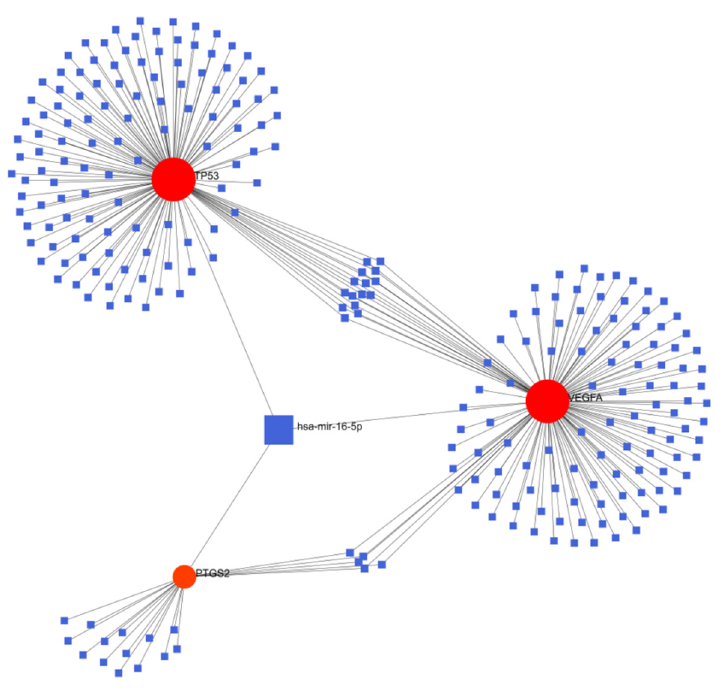
Figure 10. Interactions among 3 hub genes and miRNAs. After this, the TP53, VEGFA, and PTGS2 hub genes’ gene-TF network was built, and PHD finger protein 8 (PHF8), Sin3a associated protein 30 (SAP30) and Iysine demethylase 5B (KDM5B) were identified as the common regulators of the three hub genes (Figure 11).